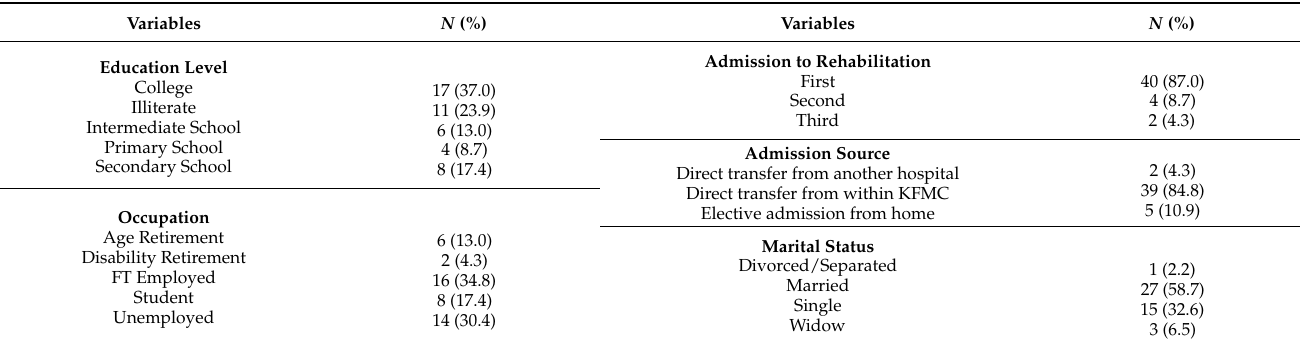
Table 1. Socio-demographic characteristics of the patients ( n = 46).